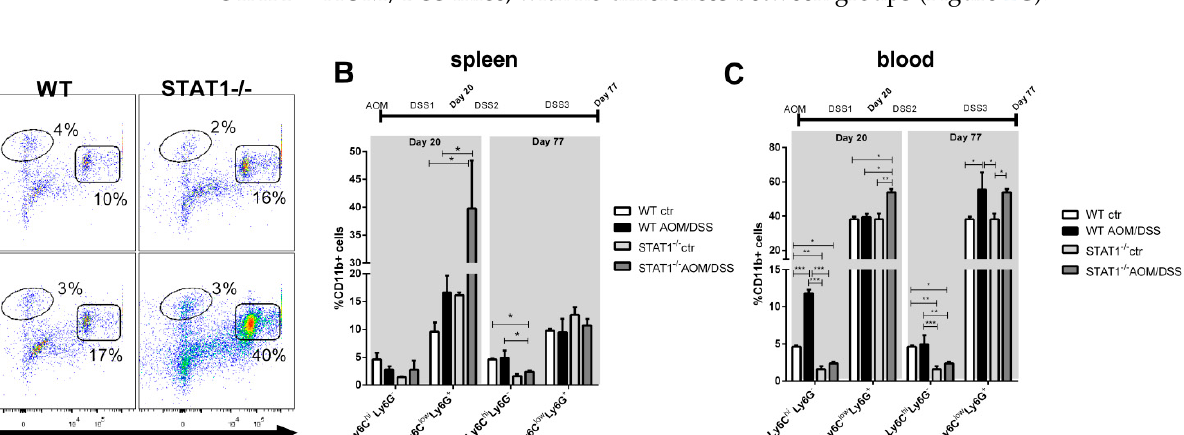
showing immunohistochemical staining of F4/80 macrophages in colon tumor sections from WT and STAT1 -/- mice treated with AOM/DSS at different times of tumor progression Scale bars: 50 µ m; ( C ) percentage of cells stained positive for F4/80; ( D ) representative dot plots showing CD11b+F4/80+ cell populations in spleens of WT and STAT1 -/- mice treated with AOM/DSS at the indicated time intervals; ( E ) percentages of CD11b+ F4/80+ cells in the splenocytes of WT and STAT1 -/- mice treated with AOM/DSS at different times of tumor progression; ( F ) immunohistochemical staining and ( G ) percentage of Ly6G+ cells in colon tissues in day 20. The quantification of Ly6G+ cells was performed using ImageJ software v.1.48 by counting cells in 10 high-powered fields from at least three slides per animal. Scale bars: 50 µ m.The red arrowheads indicate Ly6G localization. Data shown are the mean ± SE of four or five individual mice per group per day of analysis and are representative of three individual experiments with similar results per day of the analysis. * p < 0.05, ** p < 0.01, *** p < 0.001.